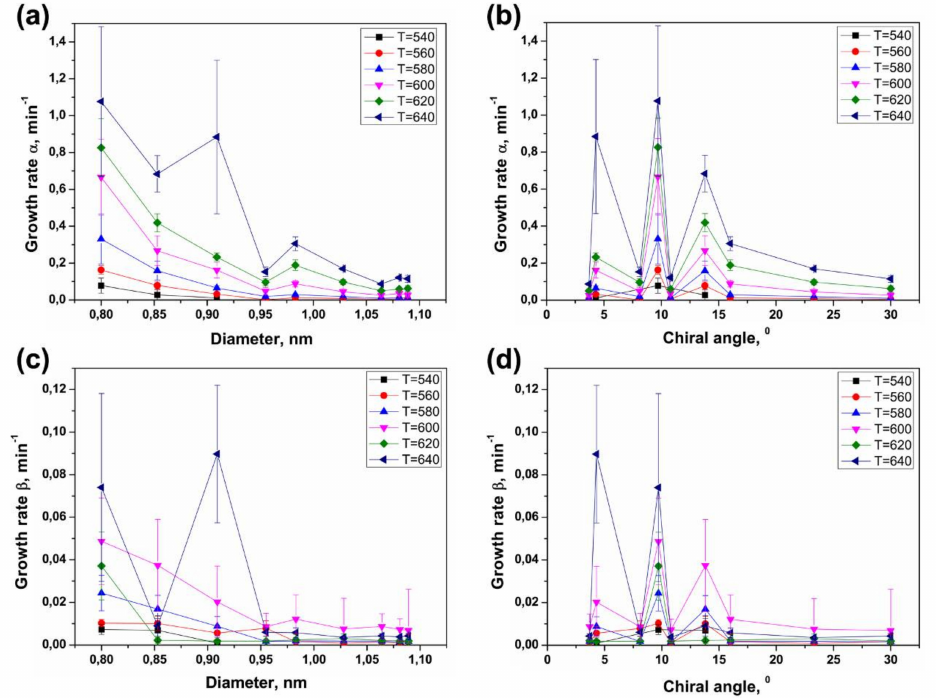
Figure 13. Growth rates α and β versus tube diameter ( a and c , respectively) and versus chiral angle ( b and d , respectively) for inner tubes with chiral vectors of (8,8), (12,3), (13,1), (9,6), (10,4), (11,2), (11,1), (9,3) and (9,2) formed upon in situ annealing of the cobaltocene-filled SWCNTs at temperatures in a range from 540 to 640 ◦